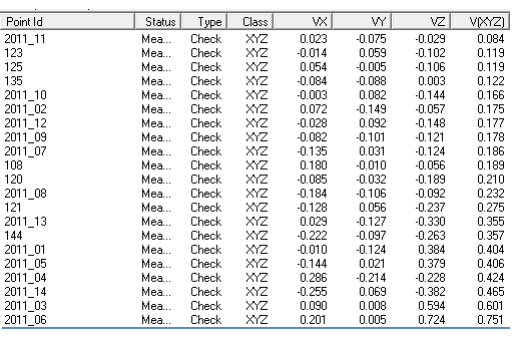
Table 6. Check Point